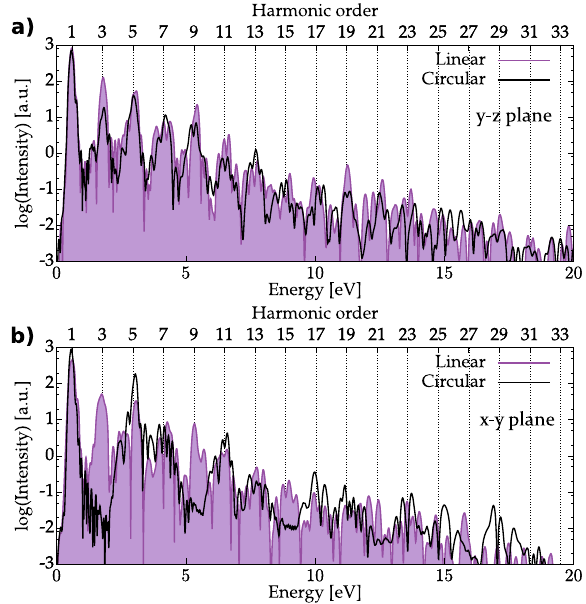
Fig. 2 High-harmonic generation from Na 3 Bi. Harmonic spectra obtained for linearly-polarized driving fi eld (violet curves) and for circularly-polarized driving fi eld (black lines) for ( a ) the y − z polarization plane, and ( b ) the x − y polarization